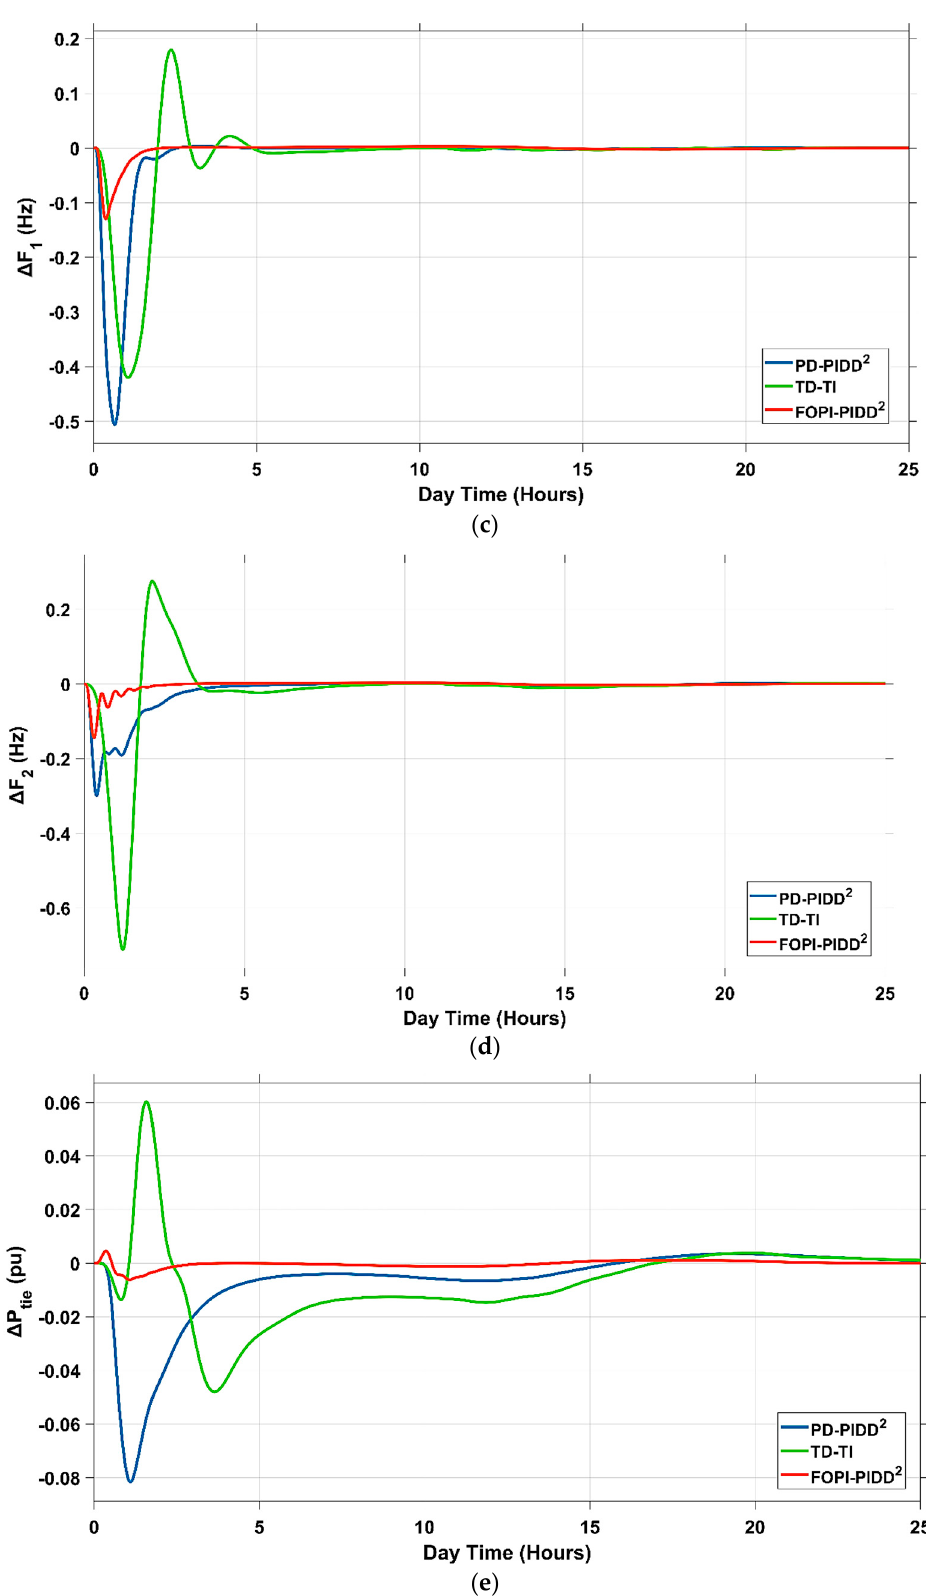
Figure 25. Comparison of PD–PIDD 2 , TD–TI, and FOPI–PIDD 2 optimized by DO algorithm for scenario 3: ( a ) V 1 , ( b ) V 2 , ( c ) Δ F 1 , ( d ) Δ F 2 , and ( e ) Δ P tie .